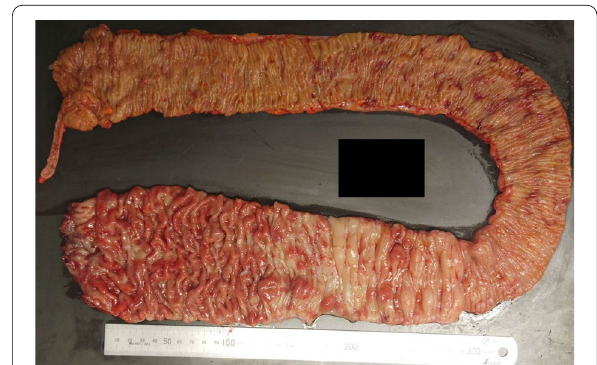
Fig. 1 Total colonoscopy examination. The mucosa is reddened and there are multiple raised lesions from the middle transverse colon to the rectum. There is white moss on the top of the raised